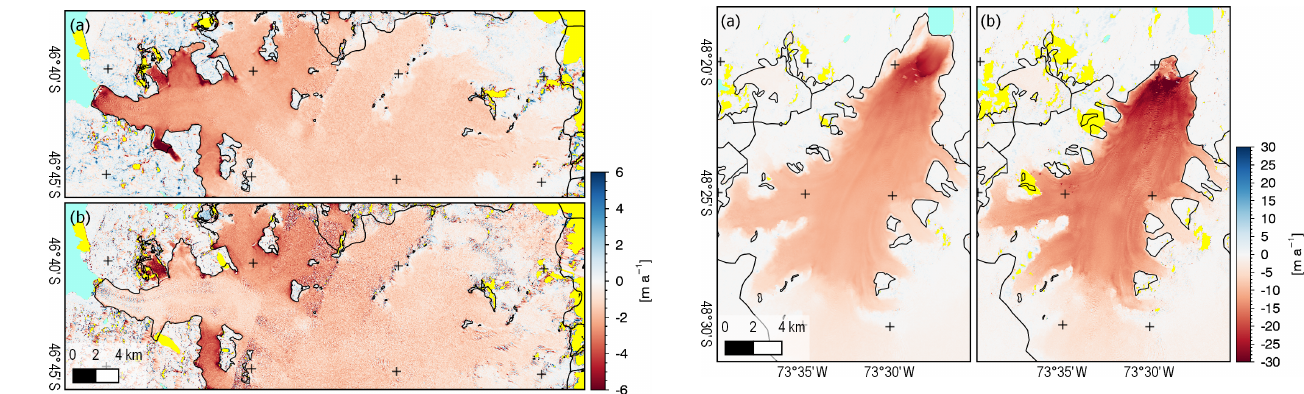
Figure 5. SECR of Jorge Montt: (a) 2000–2012, (b) 2012–2016. main factors. High loss rates (SECR < ∼ − 0 . 08 m d − 1 )